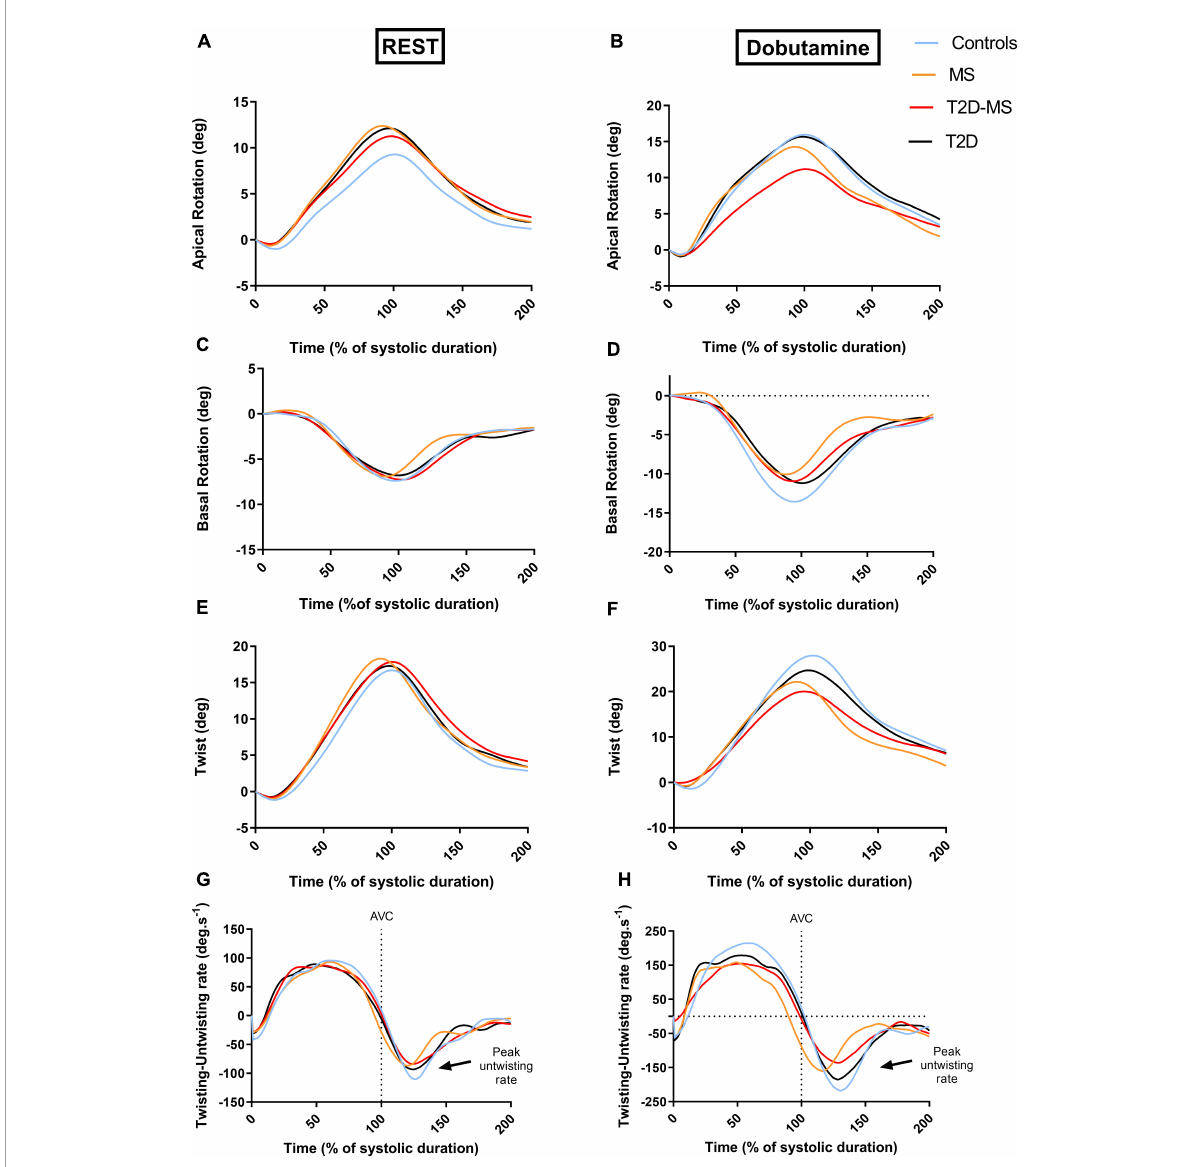
FIGURE2 Patterns of apical (A,B) and basal rotations (C,D) as well as twist and twisting/untwisting rates (E,F) all over the cardiac cycle at rest (A,C,E,G) and low dose of dobutamine (B,D,F,H) . The curve for each group was obtained from averaging data of all the subjects. For each group, data of the curves were averaged at every percent of systolic duration from data of all